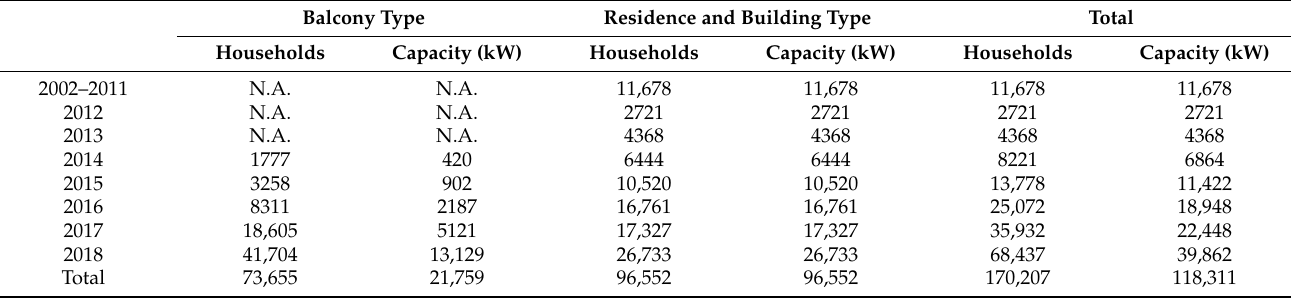
Table 4. Annual Installations of Mini-PV (Data obtained from Seoul Energy Corporation on 14 February 2019). Balcony